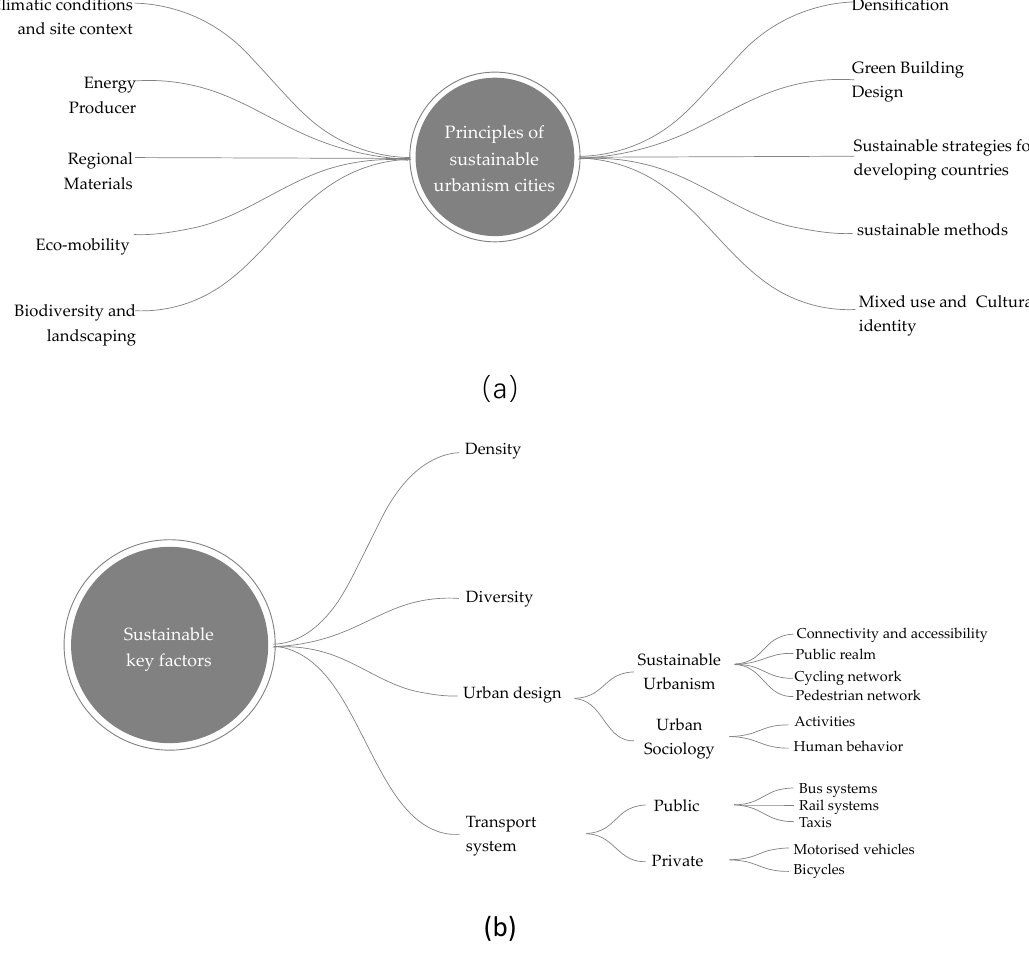
Figure 1. ( a ) Principles of sustainable urbanism cities; ( b ) sustainable key